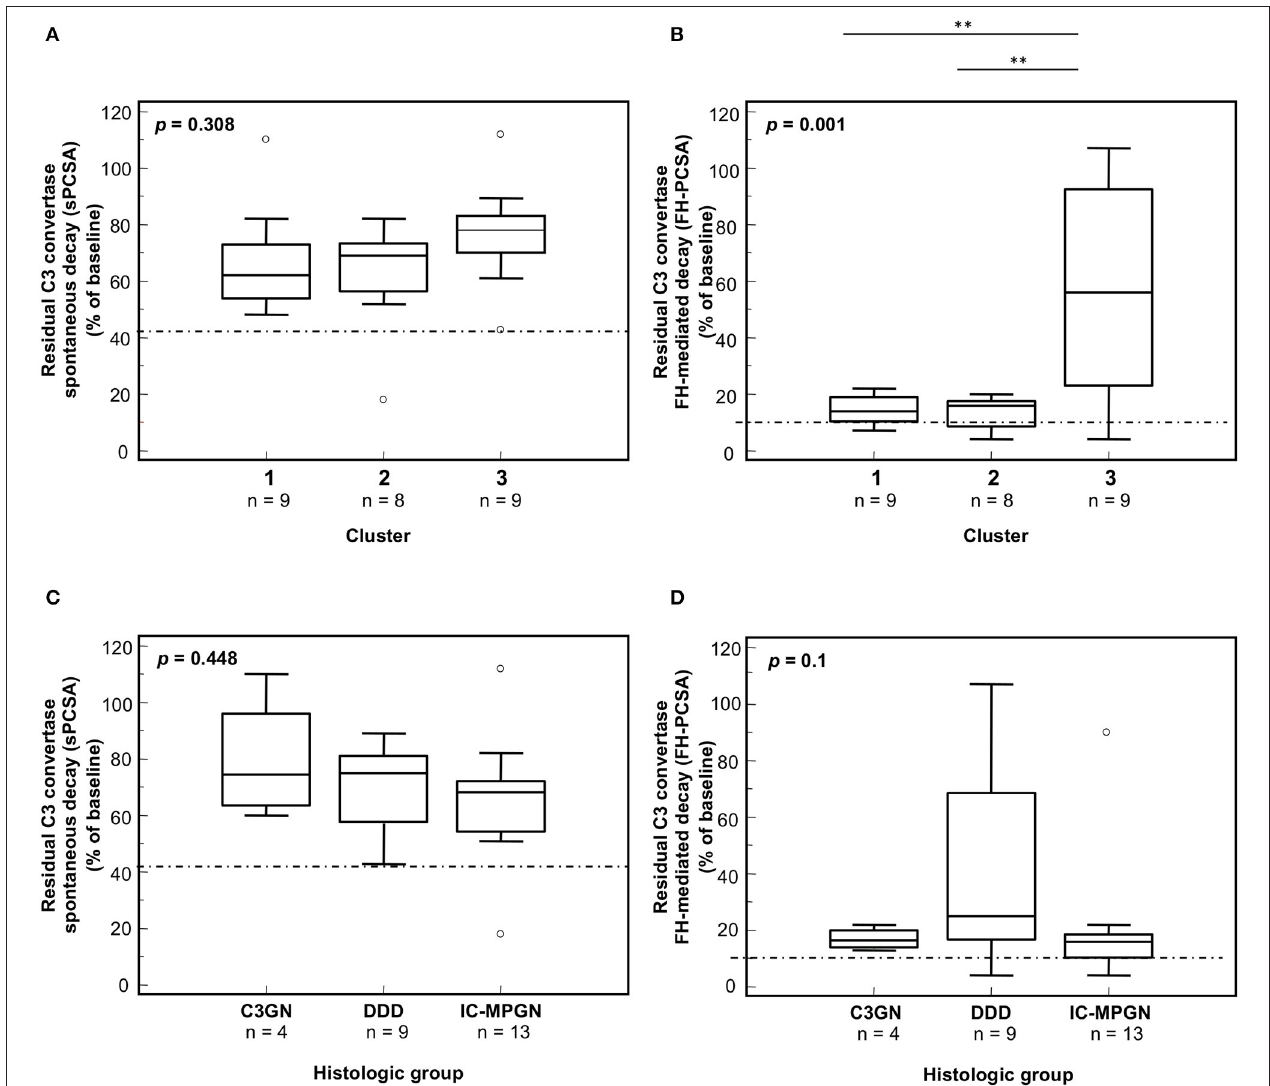
FIGURE 7 | Distribution of the C3NeF IgG C3 convertase-stabilizing activities in the presence of properdin according to the clusters and the histology groups. Box plots show that C3 convertase-stabilizing activity against spontaneous (sPCSA) (A,C) decay did not differ among clusters or histology groups. C3 convertase-stabilizing activity against FH-mediated decay (FH-PCSA) (B,D) was significantly higher in patients of cluster 3 than in patients of clusters 1 and 2. The boxes represent the values from the 25 to 75th percentiles. The horizontal bars are the medians. Vertical lines are the 95% confidence intervals. Empty circles are values outside the 95% confidence intervals. The dashed horizontal line shows the limit of positive values (set at > mean + 2SD of results with control IgGs from 26 healthy subjects). ** P <